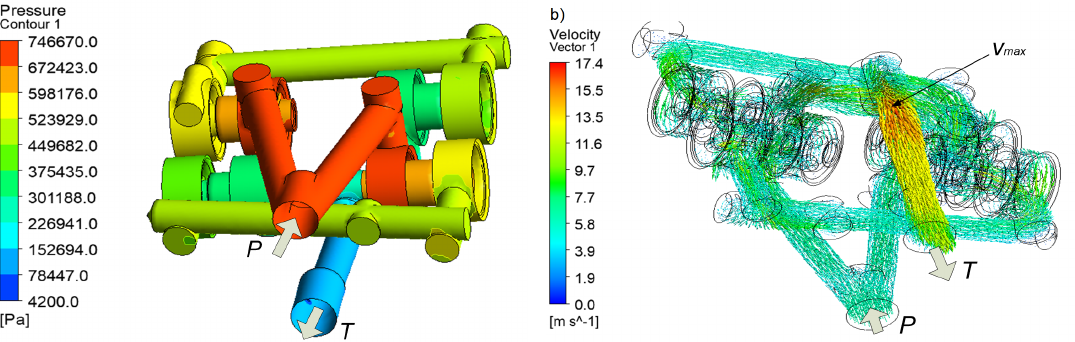
Figure 11. Simulation results obtained with the P − T flow path at a flow rate Q = 20 dm 3 min − 1 : ( a ) pressure distribution, ( b ) velocity